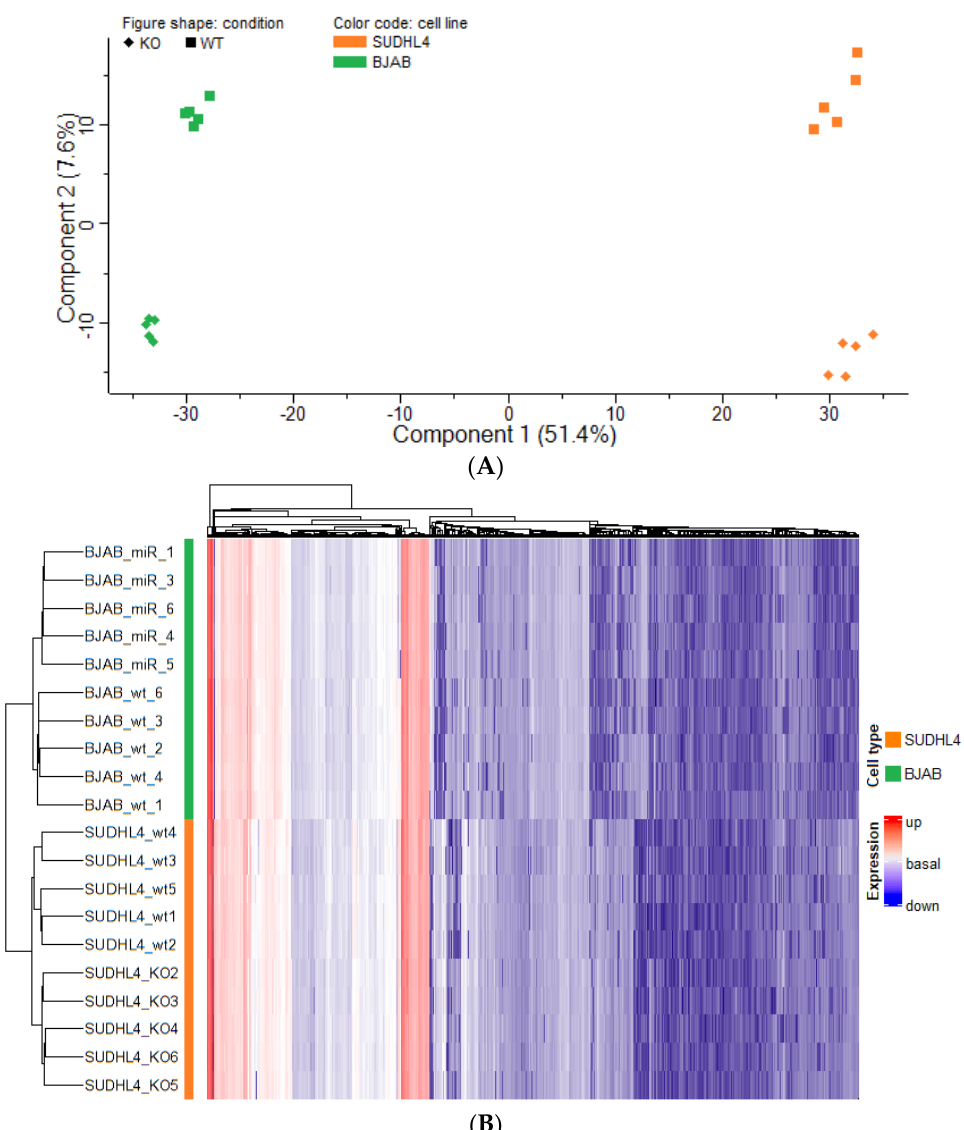
Figure 3. ( A ) Principal component analysis (PCA) of the proteome profiles from BJAB and SUDHL4 cell lines with either a wild-type or a miR-142 knockout genotype. Each data point represents a single biological replicate. Colors indicate the cell line, shapes for the genotype. ( B ) Heat map and unsupervised hierarchical clustering of protein intensity values from each of the replicate per cell line, and per genotype.